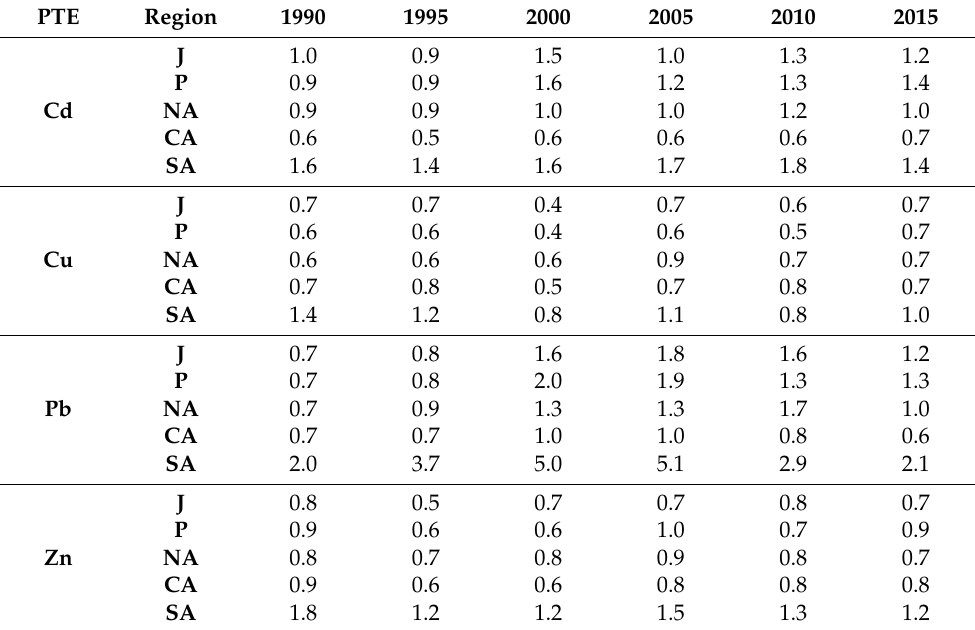
Table 2. Bioaccumulation ratios (median values) at the five Swiss biogeographic regions during the six European moss surveys, using annual background values and the remaining 65 sampling sites. See Figure 1 for explanation of regions. PTE